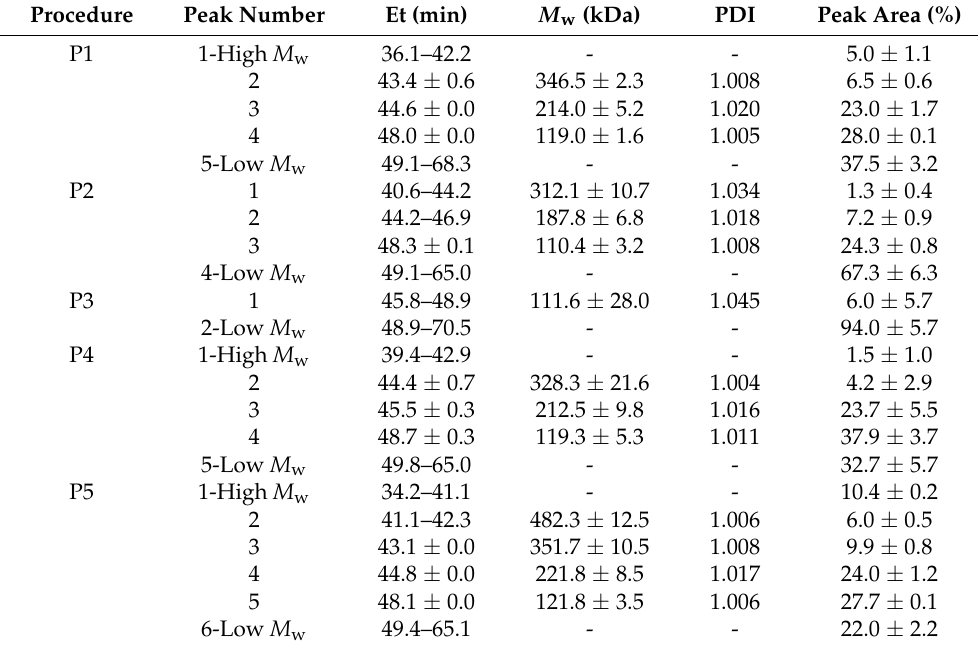
Table 5. Molecular weight (kDa) of the distributions of gelatin from salmon shown in Figure 1. Et: elution time; M w : weight average molecular weight; M n : number average molecular weight; and PDI: polydispersity index. Peak area (%) corresponds to refractive index detector. Values are represented as the mean ± standard deviations ( n =